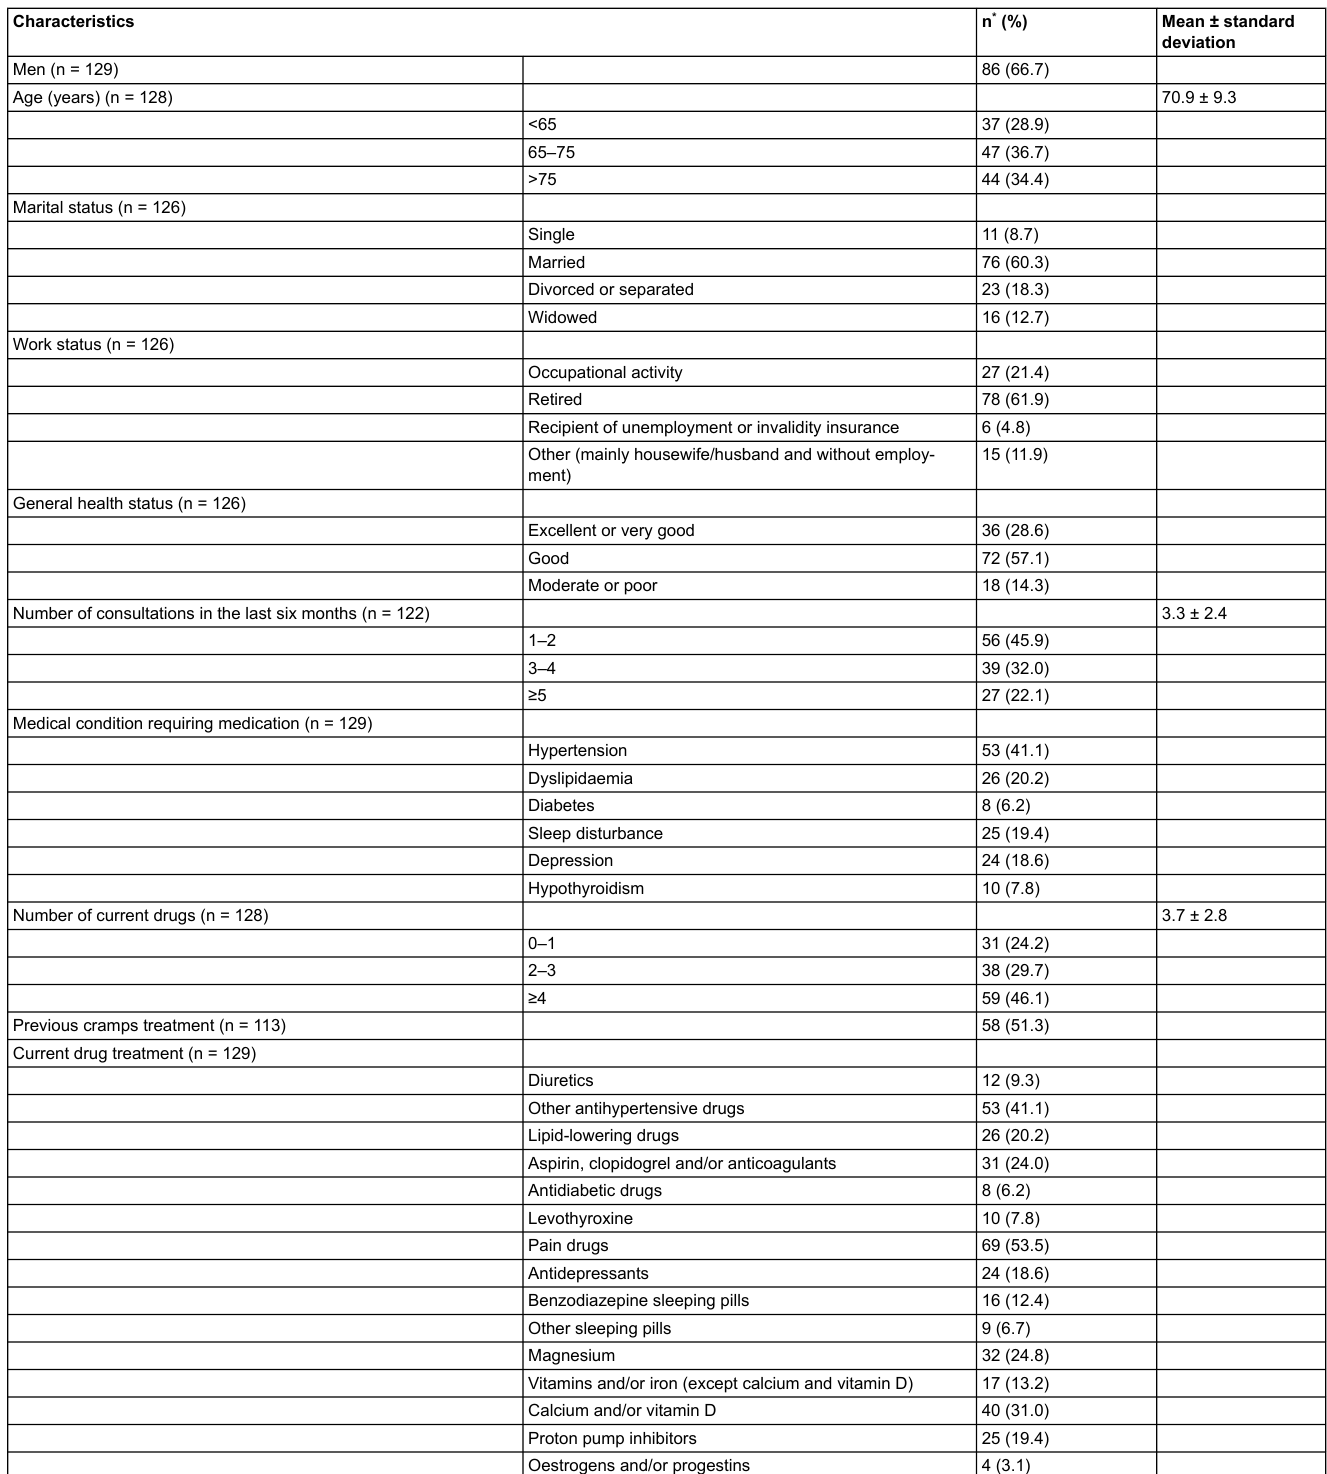
Table 1: Patient characteristics (n =